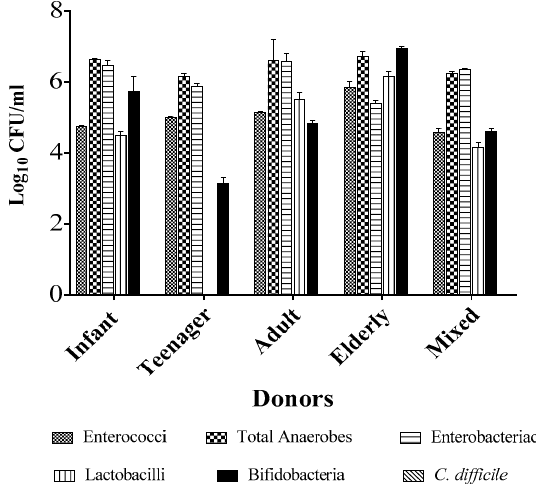
Figure 1. Contributory culturable bacterial counts from each of the individual donors and final cumulative counts of each bacterium added to the fermentation vessels. The bacteria present in the fecal sample of each donor were determined by recovery on selective medium for each bacterial grouping, after which, the samples were mixed together in relatively equal amounts and used to prime the fermentation vessels. The data was analysed using GraphPad Prism 7. Error bars are SEMs of three biological replicates.